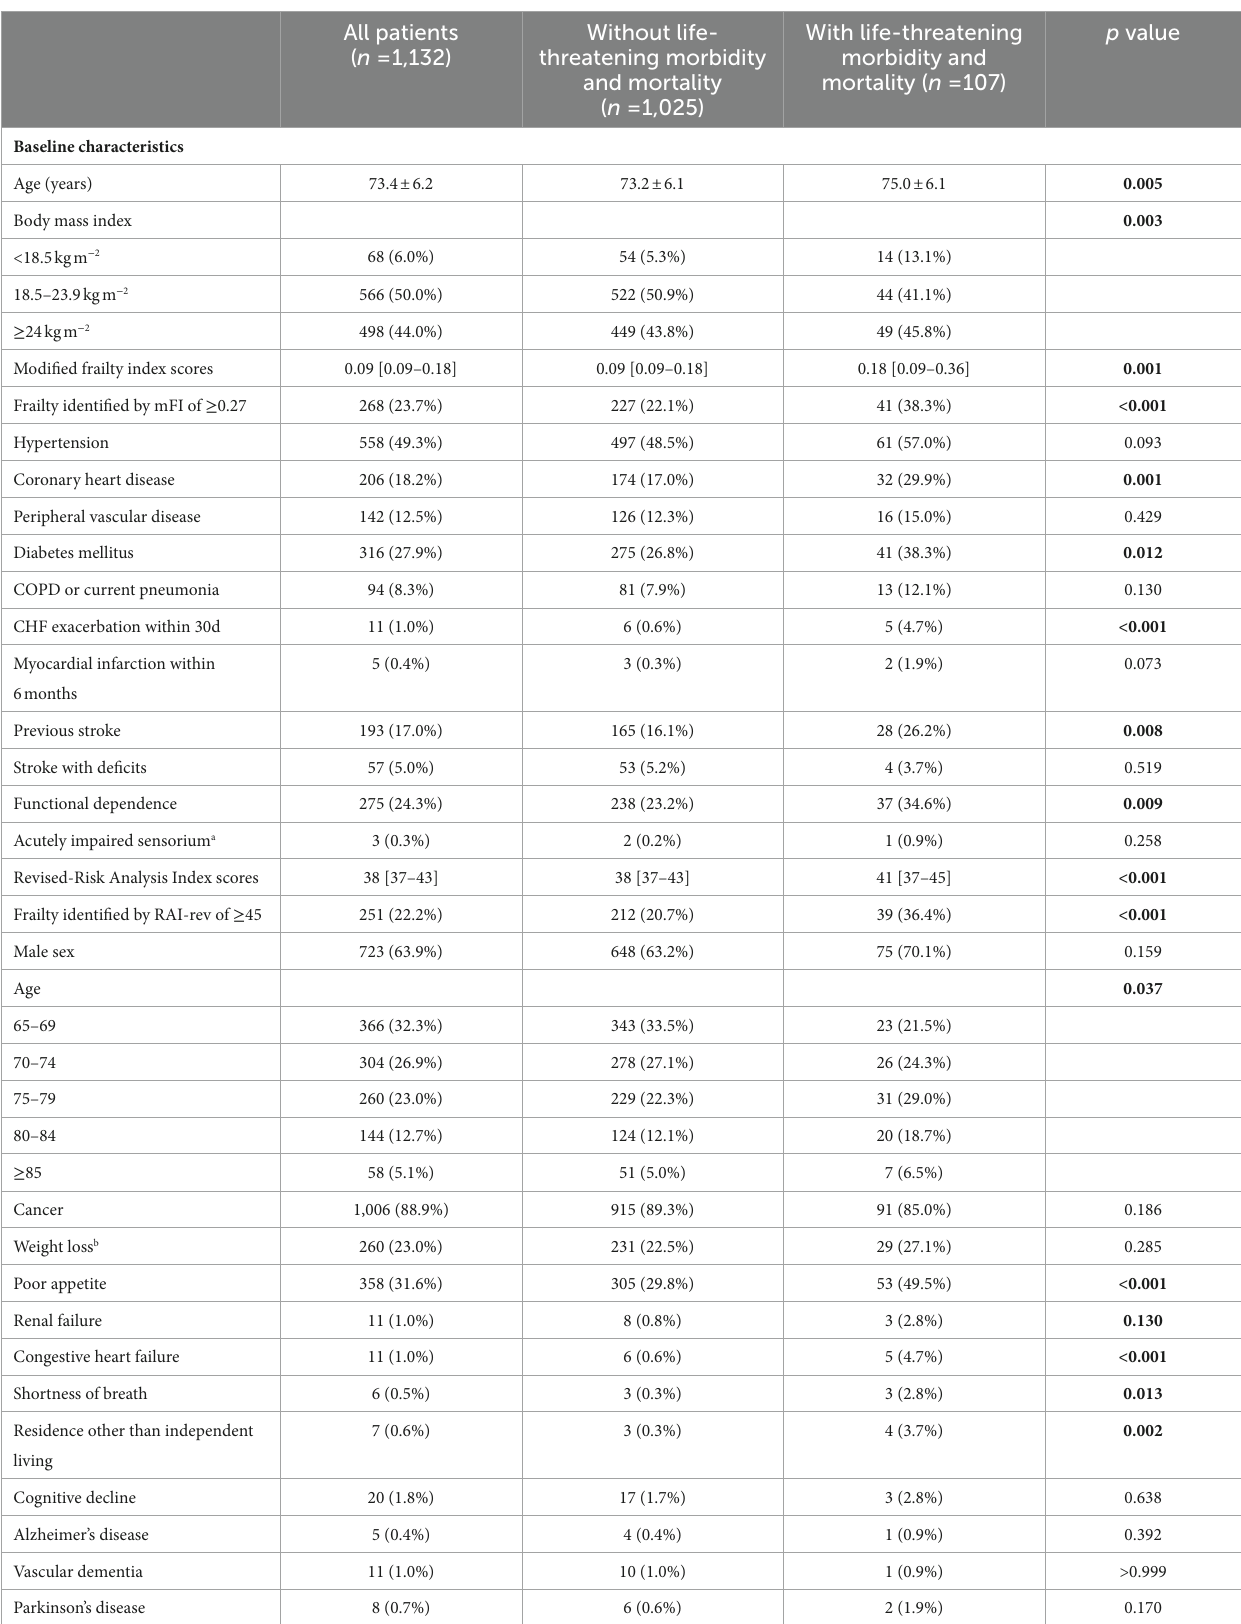
TABLE 1 Baseline and perioperative characteristics.